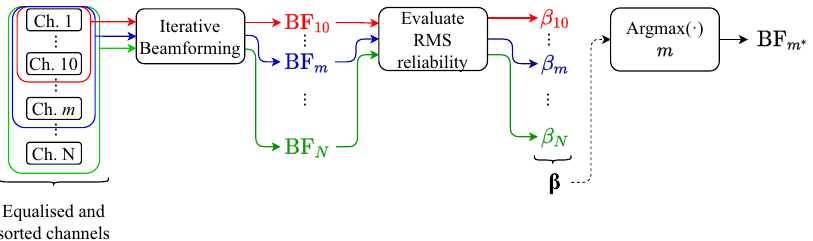
Fig. 4 Signal enhancement procedure based on beamforming spatial fi ltering. The fi rst step of the process requires an amplitude equalisation (see “ Methods ” ) of the DAS channels to eliminate the effect of geometric spreading and propagation losses, so that they result with similar amplitude levels. After this, the DAS channels (ch.) are sorted based on their reliability indicator κ i . Then, the beamforming signal BF m is formed using the m channels with p